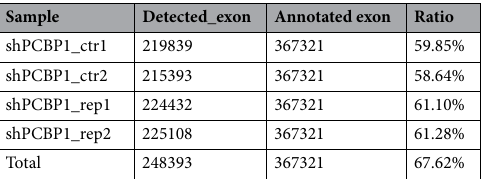
Table 1. Exon detection results in RNA-seq data. RNA-seq RNA sequencing, PCBP1 poly C binding protein 1.